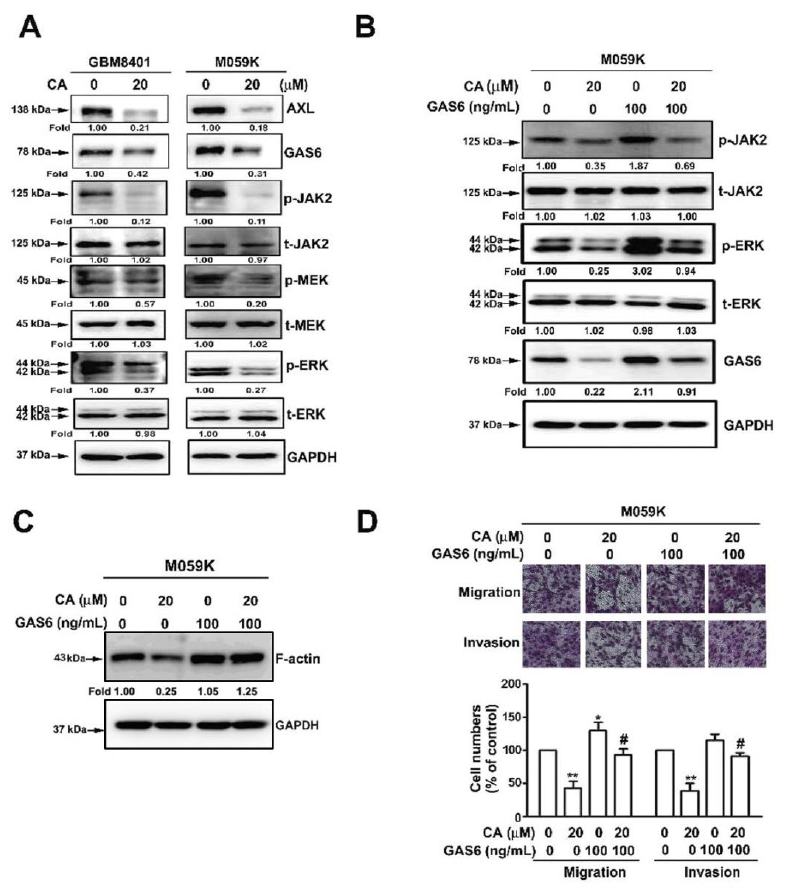
Figure 6. Involvement of GAS6-associated cascade in CA-inhibited migration and invasion of GBM cells. ( A ) Cells were treated with CA (20 μ M) and then lysed for immunodetection of the indicated targets by Western blotting. ( B , C ) Cells were treated with CA (20 μ M), GAS6 (100 ng/mL), or a combination of CA and GAS6, and then lysed for immunodetection of the indicated targets ( B ) or F-actin ( C ) by Western blotting. ( D ) Cells were treated with CA (20 μ M), GAS6 (100 ng/mL) or a combination of CA and GAS6, then subjected to migration and invasion assay. Chemiluminescence signal was semi-quantitated by densitometric analysis, and GAPDH was used as an internal control. * and ** p < 0.05 and 0.01, respectively, compared with the control (DMSO-treated cells). # p < 0.05 compared with CA alone. Images were acquired using a light microscope at 200 ×